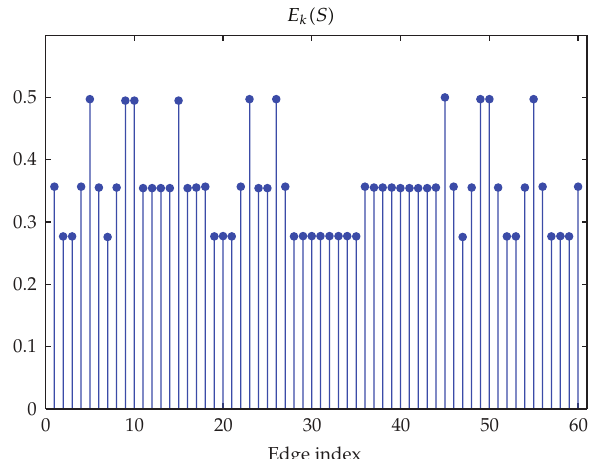
Figure 10: Edge position errors E k (cid:3) S (cid:4) for UPCA symbol encoding the message